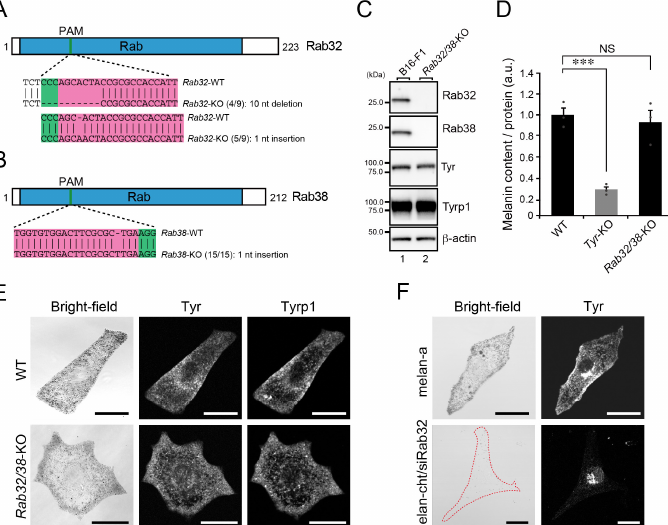
Figure 5. Black-pigmented melanosomes formed normally in Rab32 / Rab38 -KO B16-F1 cells. ( A , B ) Domain organization of the mouse Rab32 and Rab38 proteins and genomic mutations in Rab32 / 38 -KO cells. The Cas9 target and PAM sequences are highlighted in magenta and green, respectively. Genomic PCR products containing the target sites were subcloned into the pGEM-T Easy vector. Then, nine colonies for Rab32 and 15 colonies for Rab38 (denominators of the fractions in parentheses) were picked up at random and their inserts were sequenced. The numerators of the fractions in the parentheses are the numbers of colonies obtained by sequencing the subcloned PCR products. ( C ) Expression of Rab32, Rab38, Tyr, and Tyrp1 in WT cells and Rab32/38 -KO B16-F1 cells as determined by immunoblotting with the antibodies indicated. ( D ) Quantification of the melanin content (i.e . , optical density at 490 nm) in WT cells, Tyr -KO cells, and Rab32/38 -KO B16-F1 cells. The graph shows the means and SEM of the data obtained in three independent experiments. ***, p < 0.001; NS, not significant (Tukey’s test). ( E ) Representative images of Tyr and Tyrp1 in WT cells and Rab32/38 -KO B16-F1 cells, and their corresponding bright-field images. Scale bars, 20 μ m. ( F ) Representative images of Tyr in melan-a cells and Rab32-deficient melan-cht cells, and their corresponding bright-field images. Scale bars, 20 μ m.